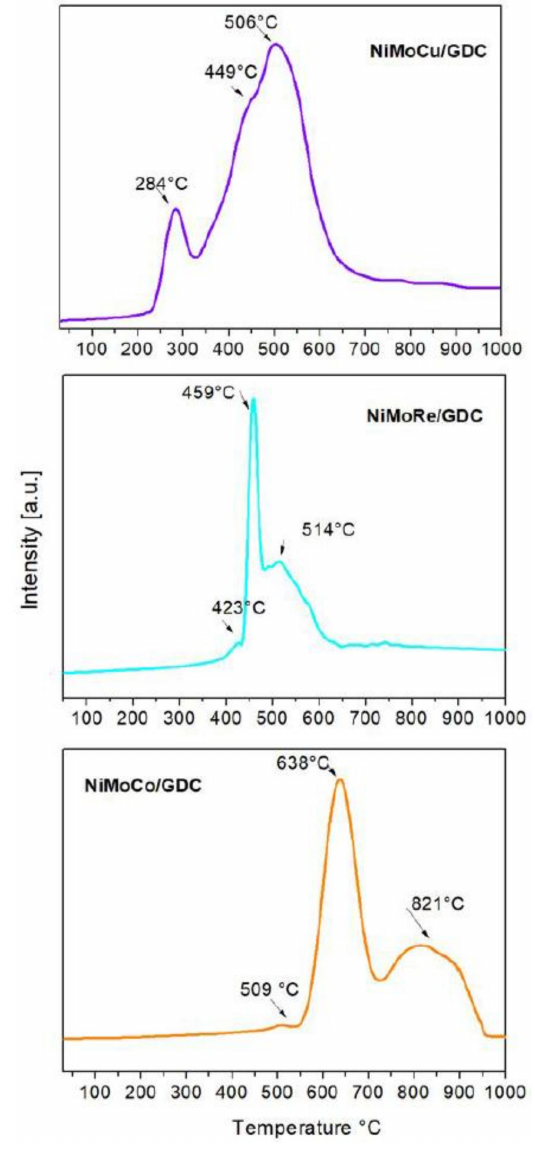
Figure 5. H 2 -TPR profiles of trimetallic